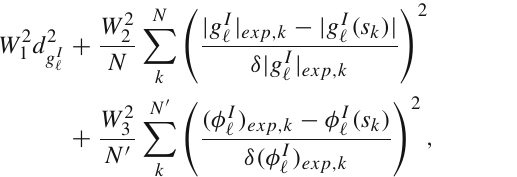
dispersion relation 0